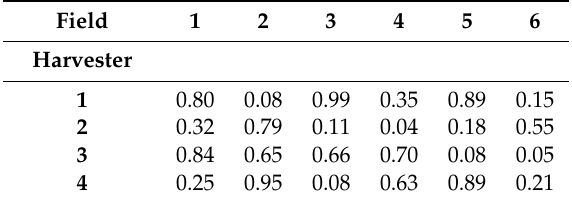
Table 2. Time (h) required to drive from the parking area of harvester set j to field k.